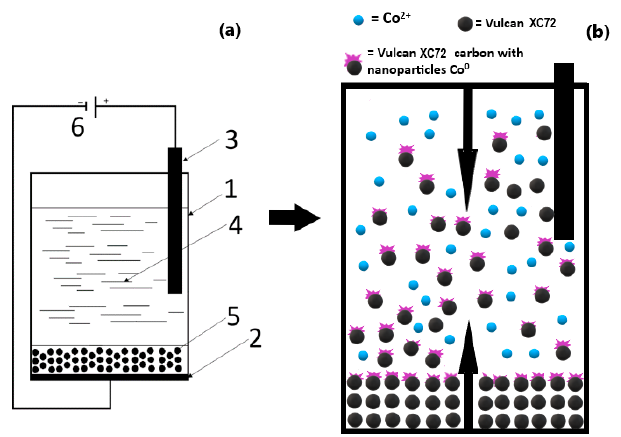
Figure 10. ( a )—Electrical scheme of an electrodeposition CoO/C materials synthesis: 1—Teflon body, 2—nickel cathode, 3—graphite anode, 4—electrolyte, 5—layer of carbon paste, 6—direct current source. ( b )—Pictorial description of a process of cobalt electrochemical deposition on carbon.